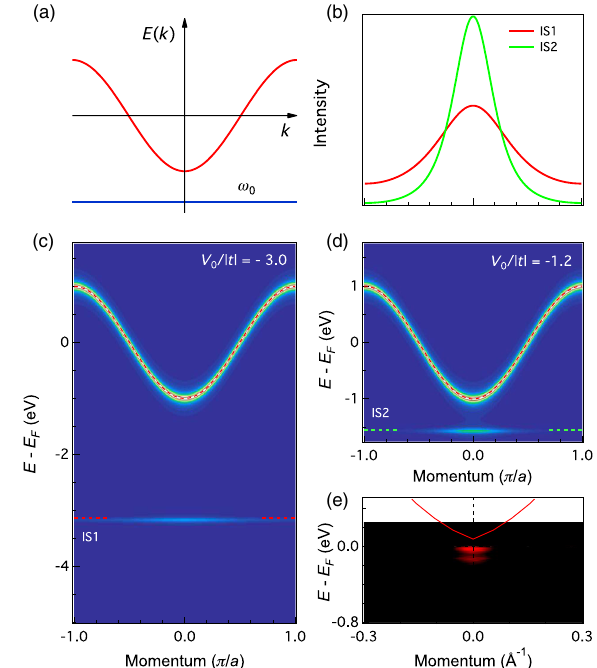
FIG. 3. (a) Schematic illustration of an impurity level below a dispersive band. (b) Comparison of the MDC at the impurity state levels IS1 and IS2 from (c) and (d). (c),(d) Numerical simulations of the spectral weight for a system with a dispersive band of the form ε ð k Þ ¼ t cos ð π k Þ (with t ¼ − 1 eV) scattering on 5% of impurities, according to Eq. (1), with V 0 = j t j ¼ − 3 . 0 and V = j t j ¼ − 1 . 2 , respectively. (e) Impurity state in Si-doped 0 β -Ga 2 O 3 , from Ref. [13]. The red curve represents the band structure obtained from local density approximation is the perturbation, with the potential V 0 characterizing the strength of the interaction. We divide the first BZ into 500 points and numerically diagonalize the resulting matrices in Eq. (1). The spectral function A ð k ; ω Þ is extracted by using